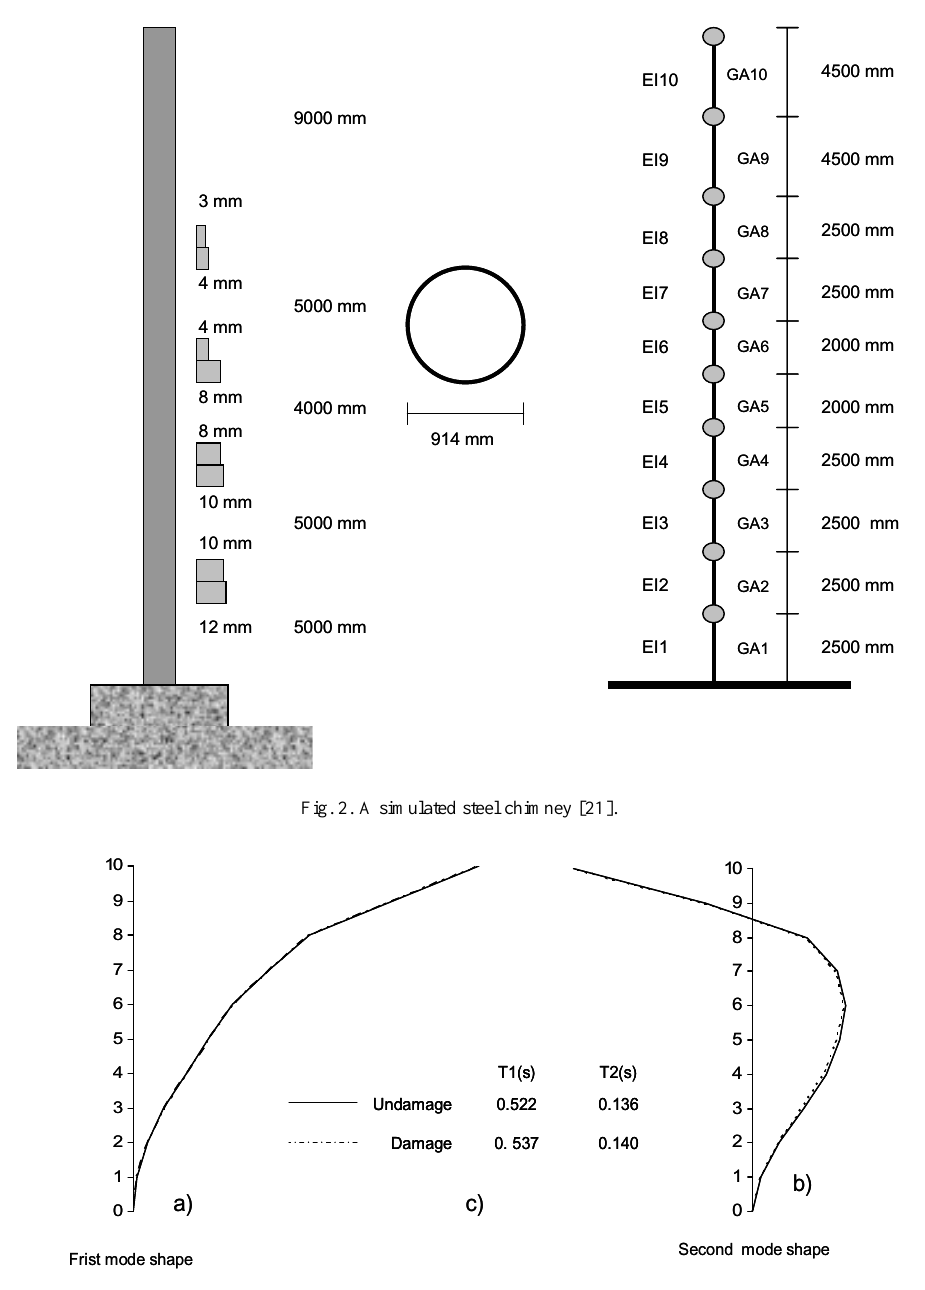
Fig. 3. Modes and periods of the